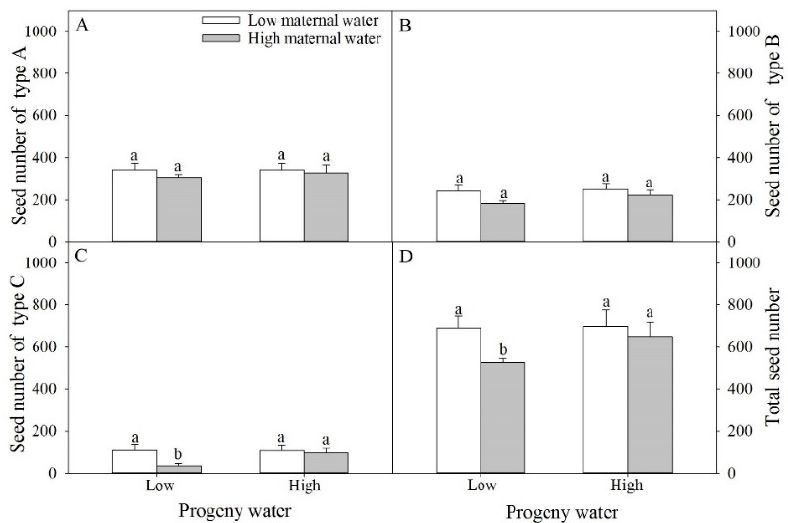
Figure 4. Effects of maternal and progeny water treatments on ( A ) seed number of type A, ( B ) seed number of type B, ( C ) seed number of type C, and ( D ) total seed number per plant. Different lowercase letters represent significantly different means between plants with different maternal water treatments under the same progeny water treatment according to t -test ( p < 0.05).